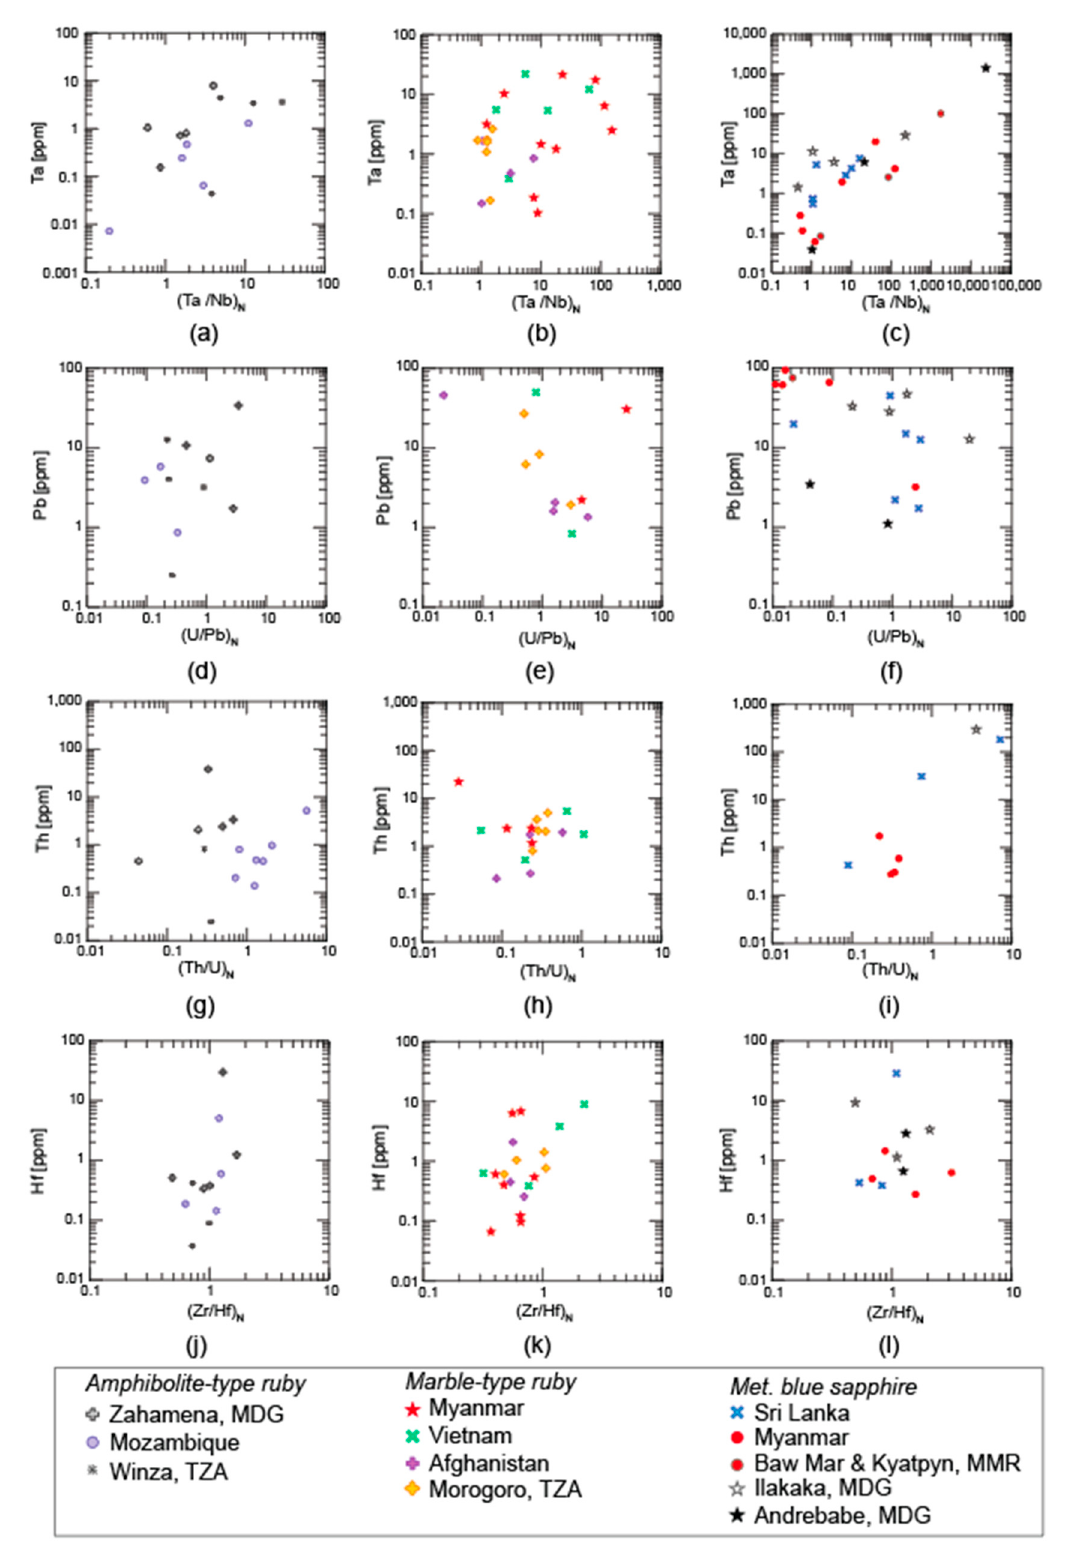
Figure 5. Primitive mantle-normalized [58] trace element compositions in offline ablated gem corundum analyzed in this study. Points represent individual analyses. ( a – c ) Ta versus (Ta/Nb) N ; ( d – f ) Pb versus (U/Pb) N , ( g – i ) Th versus (Th/U) N , and ( j – l ) Hf versus (Zr/Hf) N for amphibole-type ruby, marble-type ruby, and met. blue sapphire, respectively.